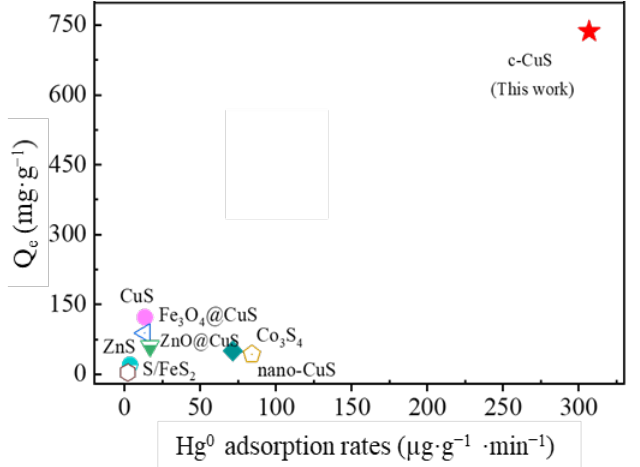
Figure 8. Comparison of adsorption capacity and rate with reported metal sulfide